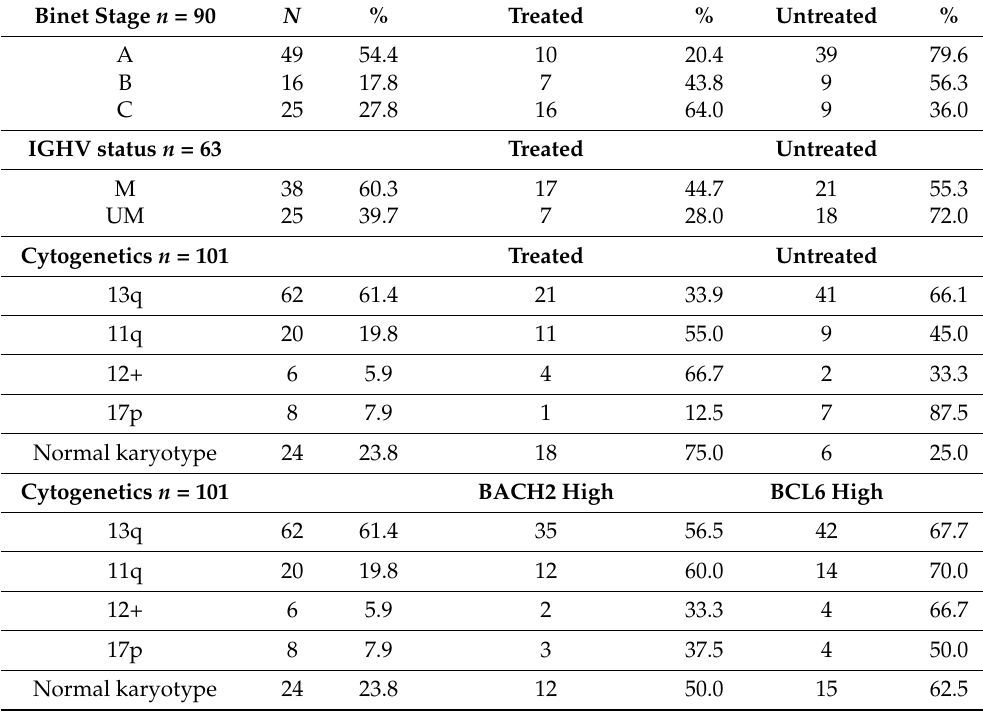
Table 2. Clinical and molecular characteristics of the CLL cohort including treatment status. Binet Stage n =